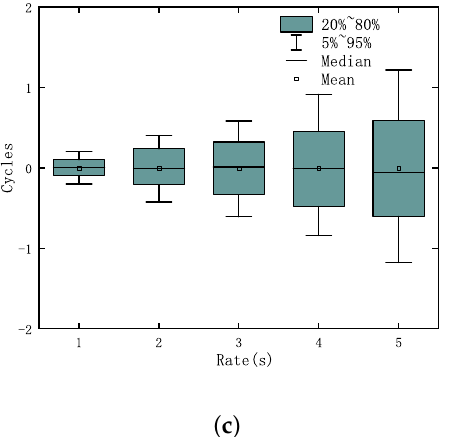
Figure 13. The Box-plot at different sampling rates: ( a ) dual-frequency cycle slip detection method; ( b ) Doppler method; and ( c ) high-order difference method.